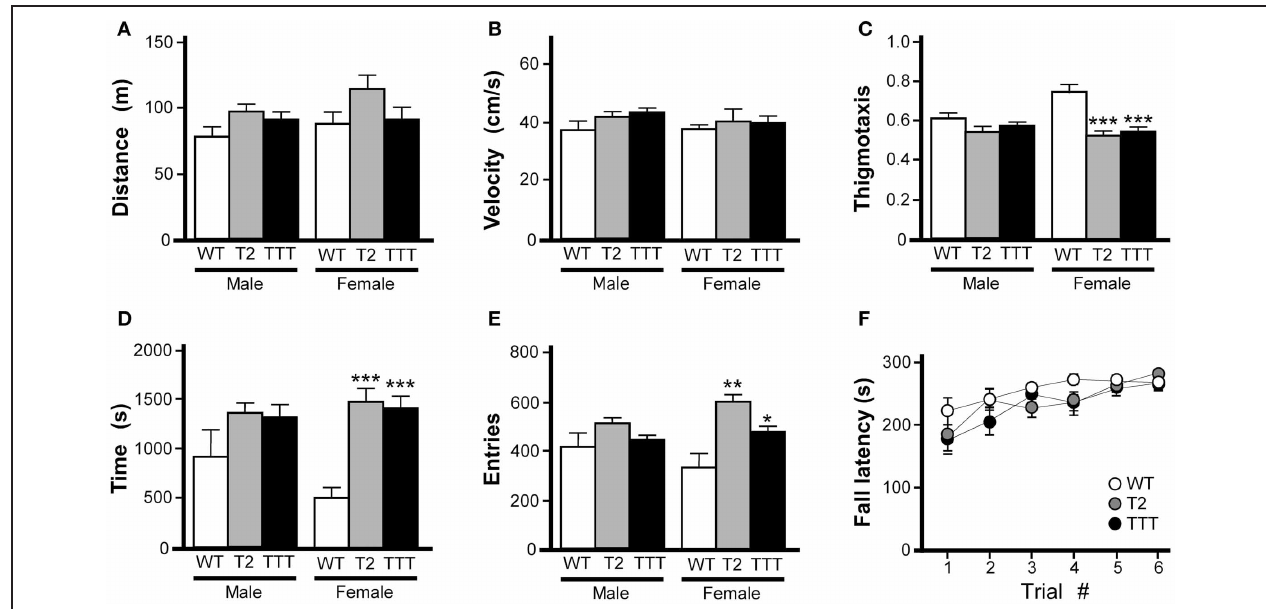
observed for male animals [ F ( 2 , 29 ) = 3 . 4, P < 0 . 05], though post hoc pairwise comparisons did not reveal a difference between Trek 2 − / − , Trek1/2 / Traak − / − , and wild-type controls. Trek2 − / − and Trek1/2 / Traak − / − females spent significantly more time in the center than wild-type controls [ F ( 2 , 30 ) = 18 . 7, P < 0 . 0001]. (E) Number of entries into center of the open-field; no genotype-dependent differences were observed in male animals [ F ( 2 , 29 ) = 2 . 1, P = 0 . 14], whereas both Trek2 − / − and Trek1/2 / Traak − / − females made more entries into the center than wild-type controls [ F ( 2 , 30 ) = 7 . 7, P < 0 . 01]. (F) Rotarod performance of wild-type, Trek2 − / − , and Trek1/2 / Traak − / − mice, measured over six separate trials ( n = 11–18 per group). A main effect of trial number was observed [ F ( 5 , 228 ) = 8 . 80, P < 0 . 001]; within-genotype, pair-wise comparisons are not shown on the plot. A main effect of genotype was not detected [ F ( 2 , 228 ) = 3 . 0, P = 0 . 06], nor was there a significant interaction between trial and genotype [ F ( 10 , 228 ) = 0 . 8, P = 0 . 62]. Symbols: ∗ , ∗∗ , ∗∗∗ P < 0 . 05, 0.01, and 0.001, respectively, vs.